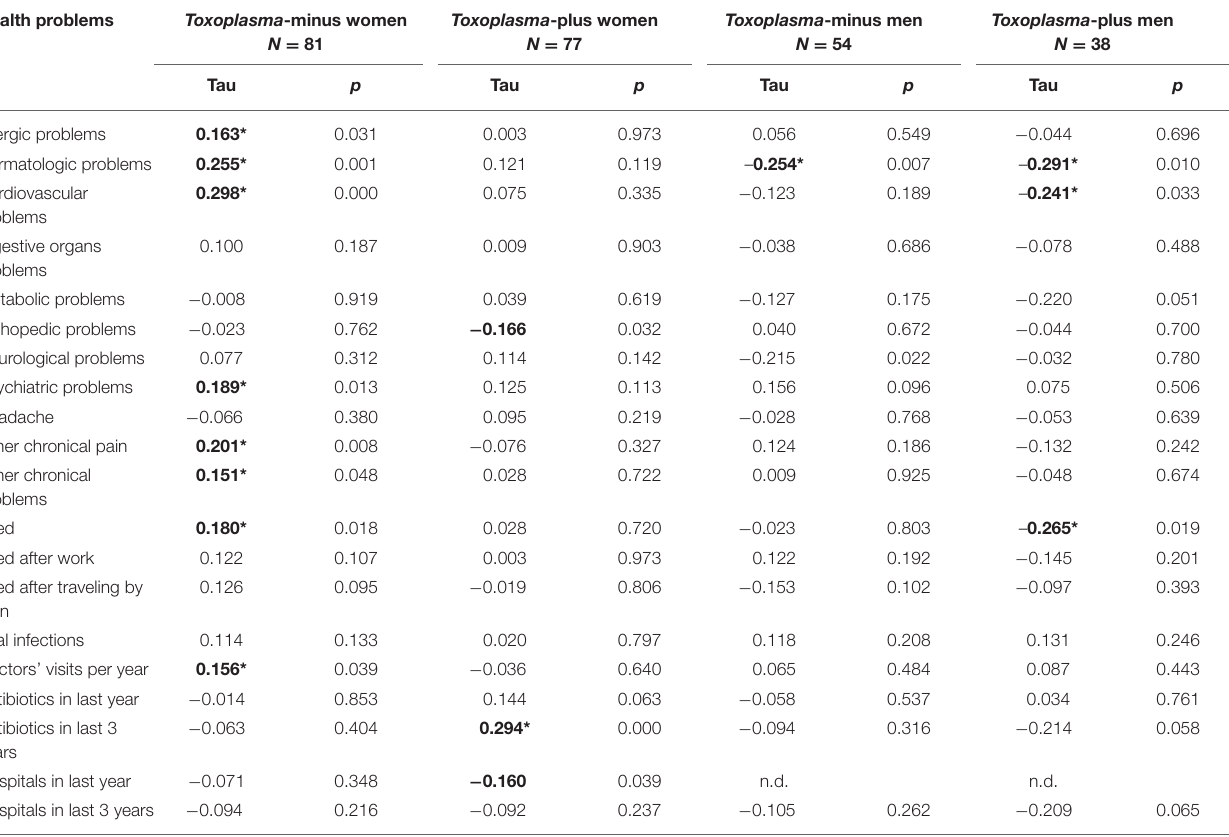
TABLE 3 | Correlation between Bartonella seropositivity and health status in Toxoplasma -seronegative and Toxoplasma -seropositive